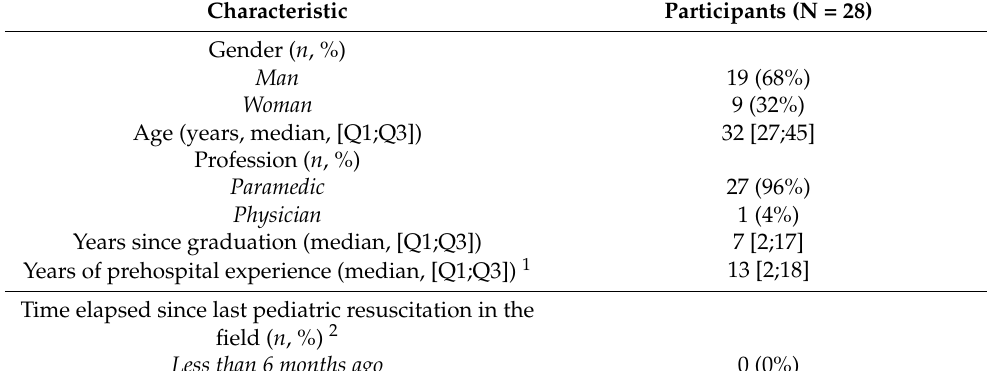
Table 1. Characteristics of study